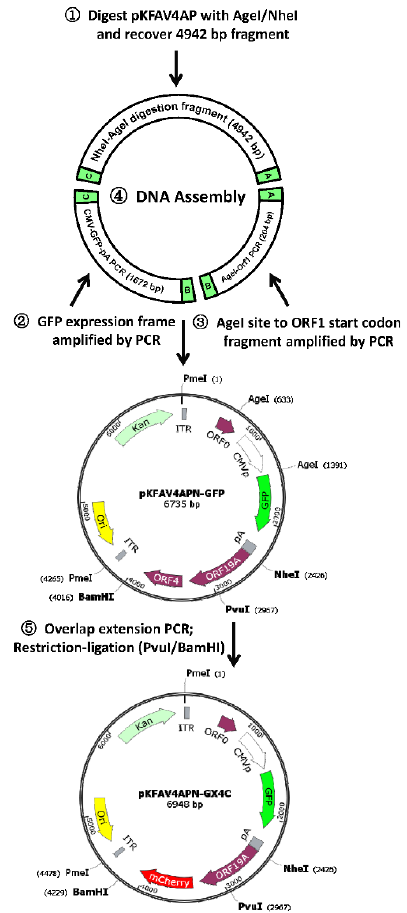
Figure 2. Schematic diagram for constructing small plasmid bearing fluorescent protein reporter genes. The DNA assembly of two PCR products and AgeI/NheI fragment in pKFAV4AP created plasmid pKFAV4APN-GFP (pKFAV4AP NheI-GFP), in which ORF1, ORF1b and ORF2 were replaced with Enhanced Green Fluorescent Protein (GFP) expression cassette. The ORF4 coding sequence (CDS) was